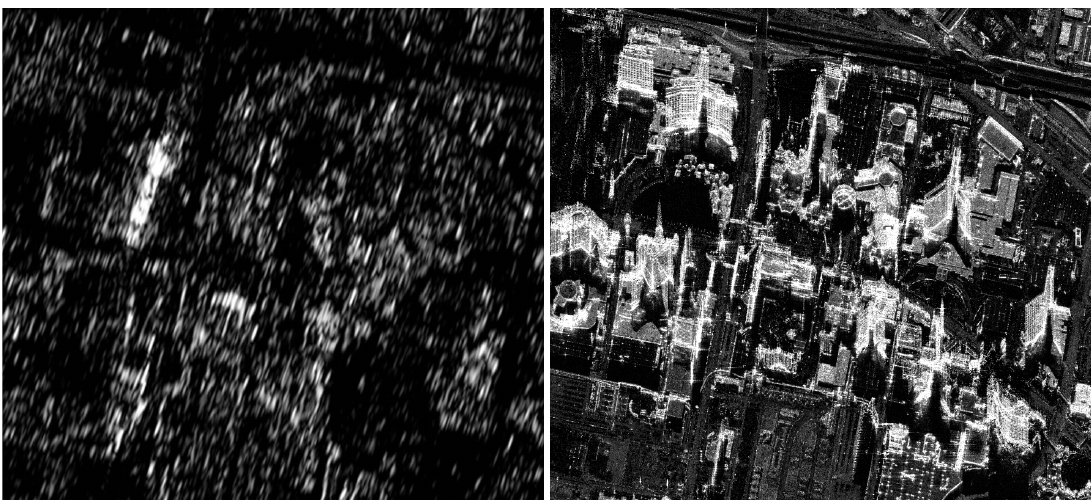
Figure 1. Comparison of medium (ERS) and high (TerraSAR-X) resolution SAR images of downtown Las Vegas